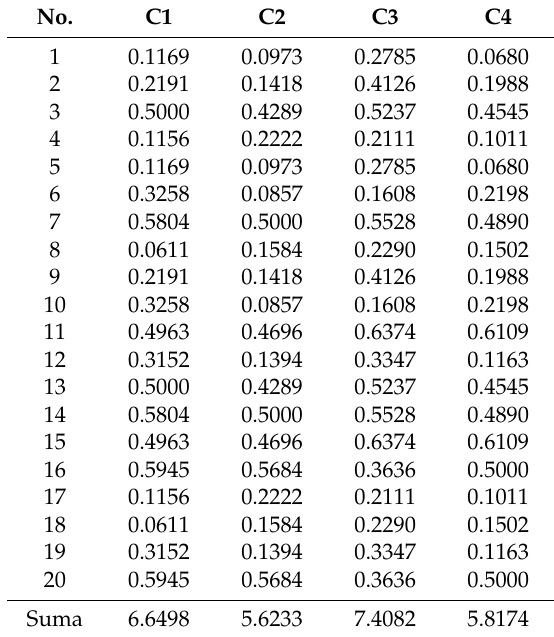
Table 3. Deviations between the criteria in matrix N C 1 − C 4 .